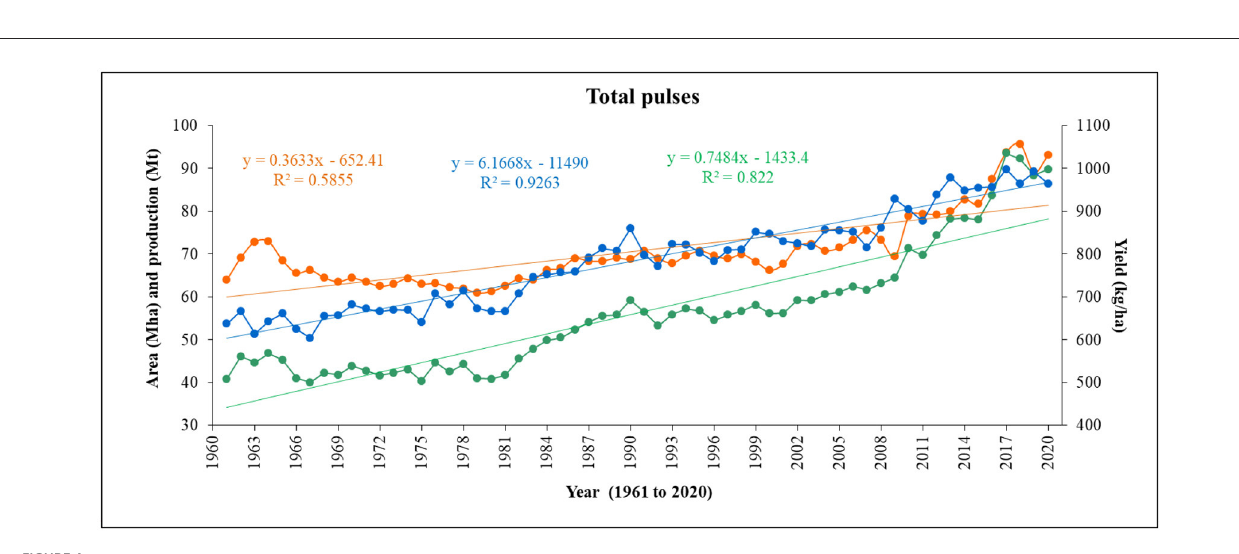
FIGURE4 Temporal variability in total area, production, and yield of pulses in the world over the last 60 years (1961–2020) (Data sources: FAOSTAT,